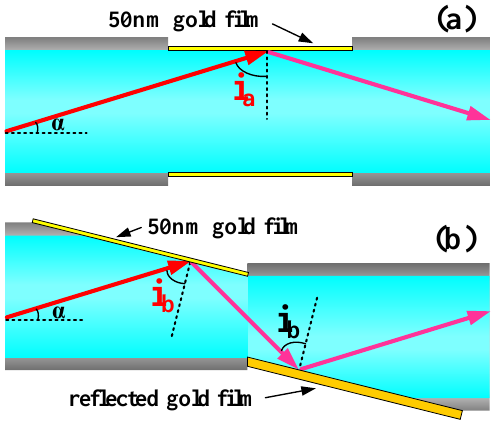
Figure 2. ( a ) Schematic diagram of a transmission-type SPR probe of multi-mode fiber; ( b ) Schematic diagram of a vitreous-clad fiber SPR probe with inclined structure.